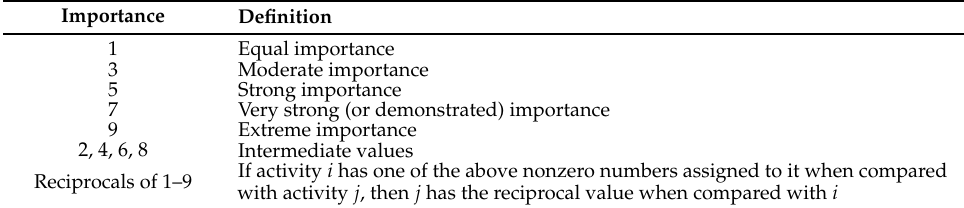
Table 2. Saaty’s fundamental